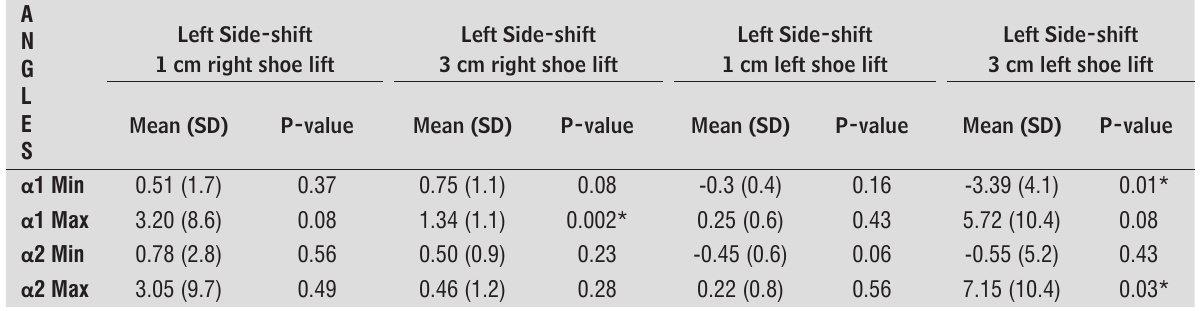
Table 3 - Difference between means (maximum and minimum) of α 1, α 2, α 3 and α 4 in side-shift movements to the left with shoe lifts of 1 cm and 3 cm in relation to the static position and p